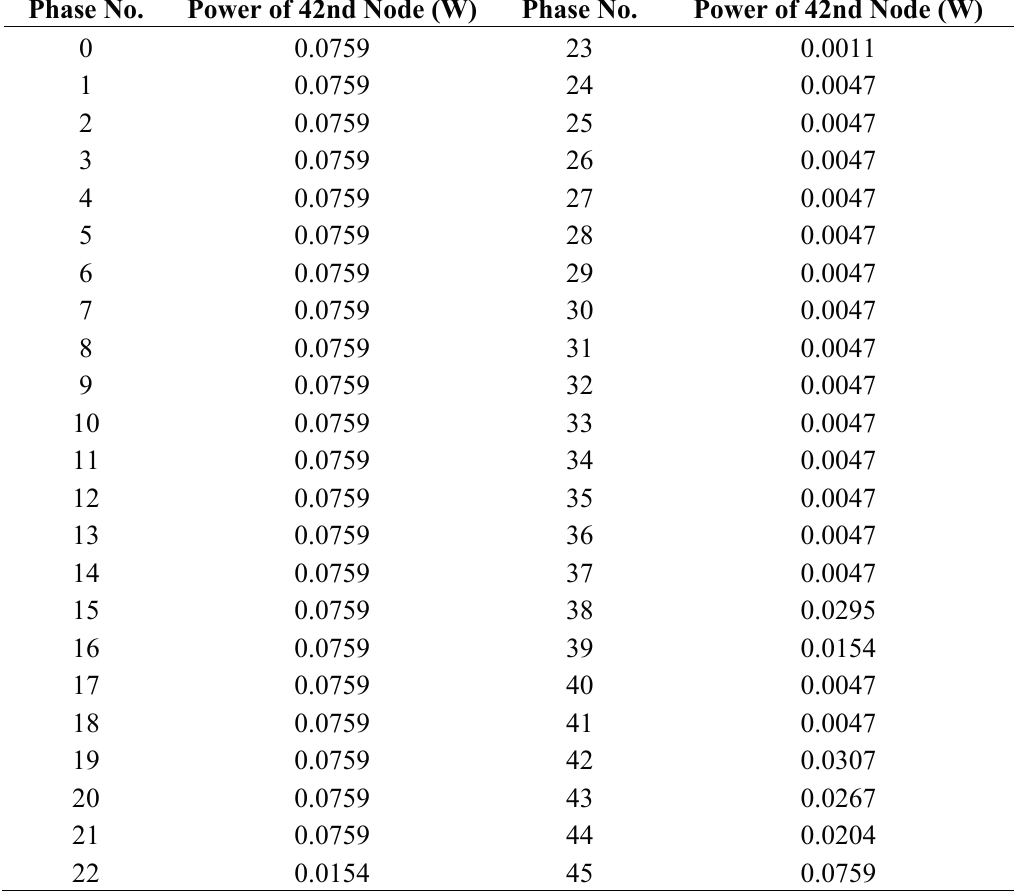
Figure 12. The travelling path for the extra replenishing assignment. Table 4. Power usage of the 42nd sensor node in each